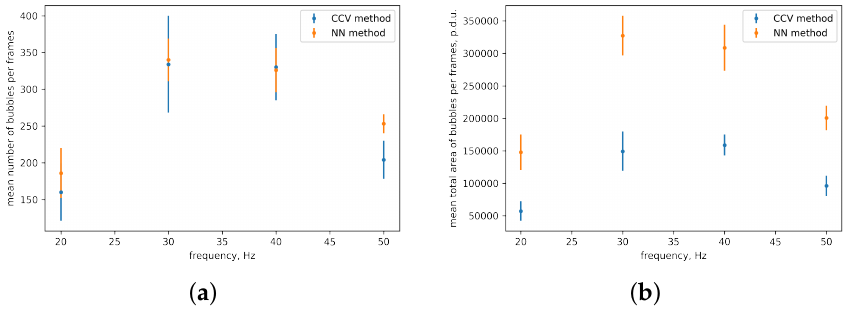
Figure 33. Ratio between the arithmetical mean of ( a ) number and ( b ) total area of bubbles per frame and bioreactor modes for the classical computer vision (blue) and neural network (orange) methods. The NN method produces results with less variance for the bubble number estimation, whereas the CCV method does the same for the total area